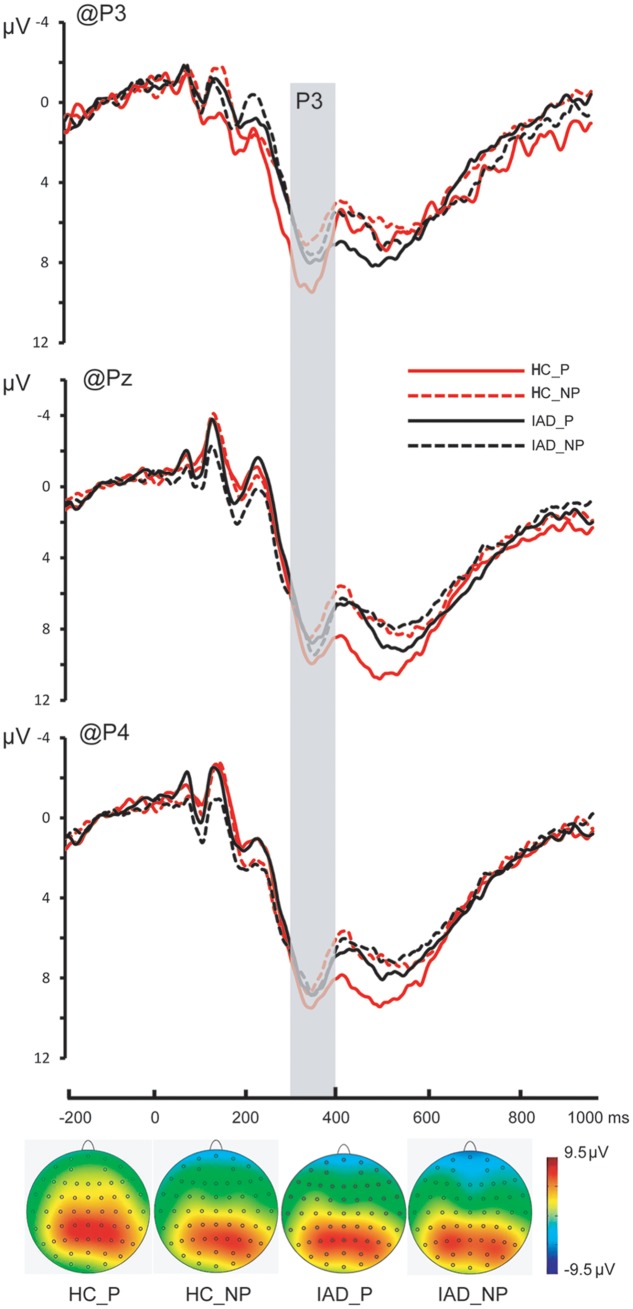
The Grand average on P3, Pz, and P4; the topography of P3 in all four conditions (the time window of the topography was corresponding to the gray square covered area).